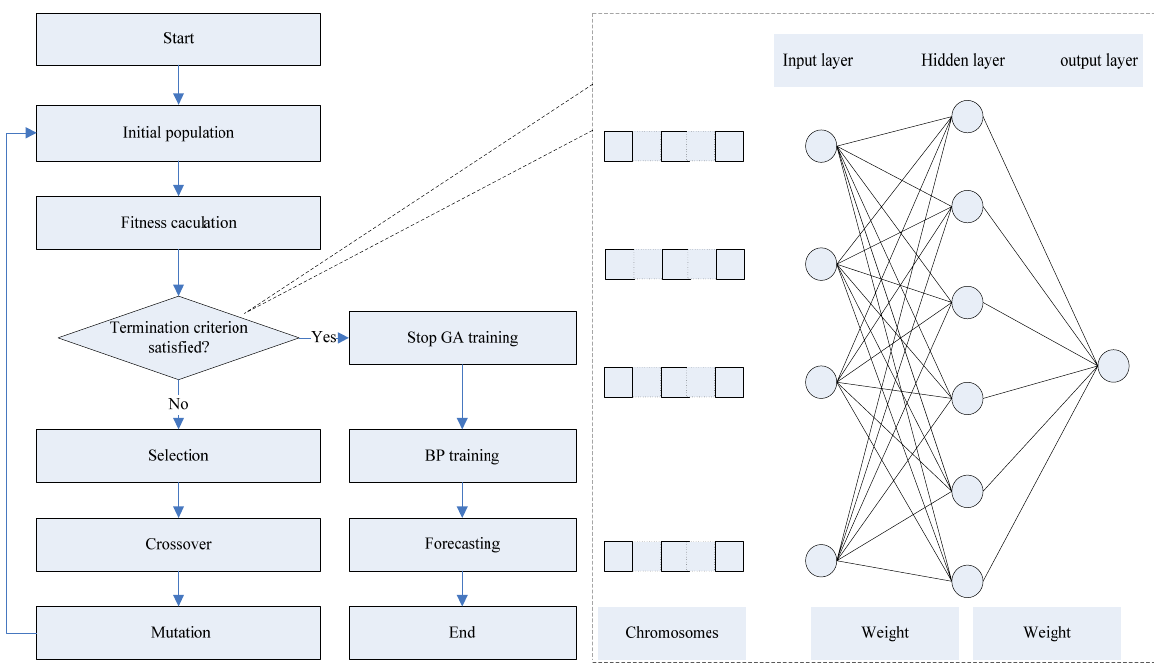
Figure 1. Framework of combining ANN and GA for